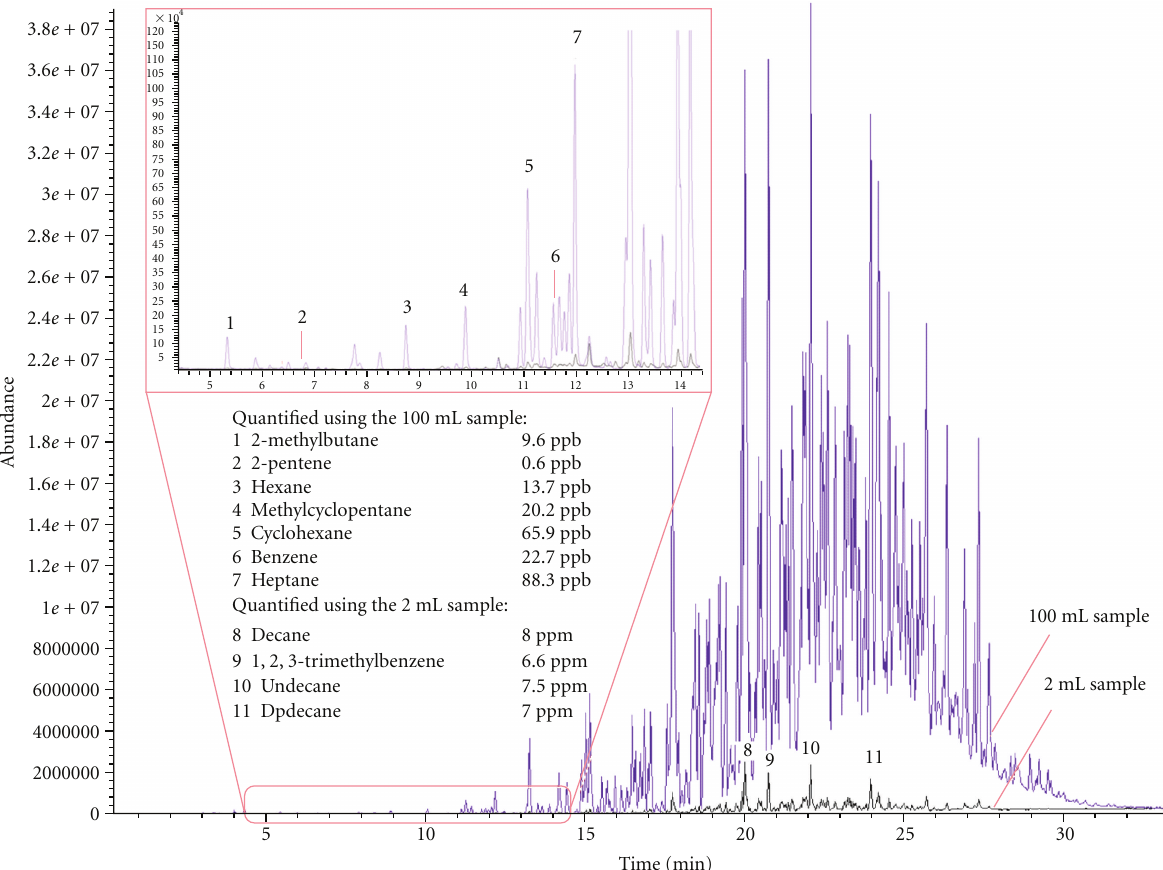
FIGURE 5: High-concentration vapours from a light diesel fraction collected into a canister and analysed using TD–GC/MS (CIA -Advantage system, Markes International Ltd); selected peaks are indicated and their approximate concentrations given. Black trace: 2 mL sample taken using a gas loop. Blue trace: 100 mL sample taken using an MFC. Inset: zoomed-in plot, demonstrating the greater sensitivity that results from using MFC sampling (method conditions are shown in Table 4).